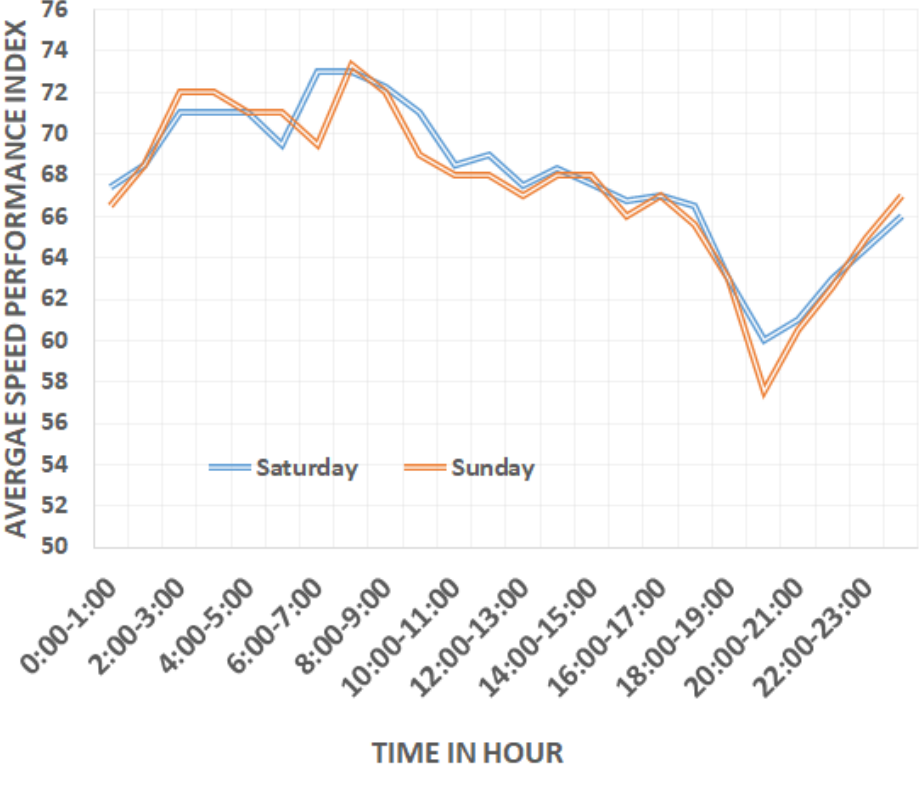
Figure 3. Speed performance index variation on